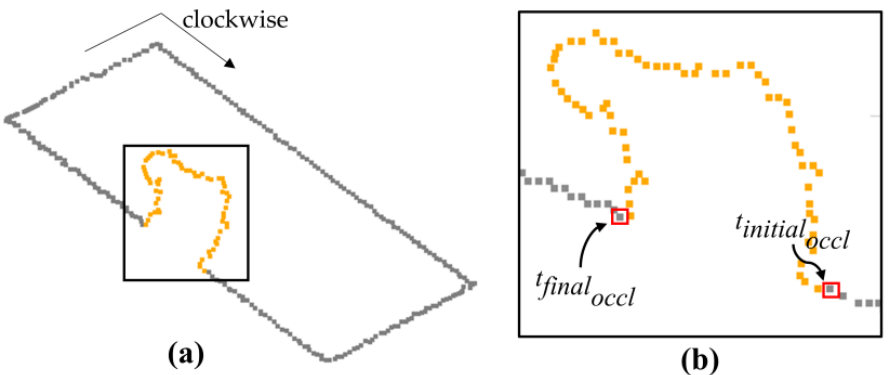
Figure 4. Building boundary with occlusion ( a ) and representation of the points related to t initial and t final ( b ). The orange points denote the contour points located in the occlusion region. occl occl